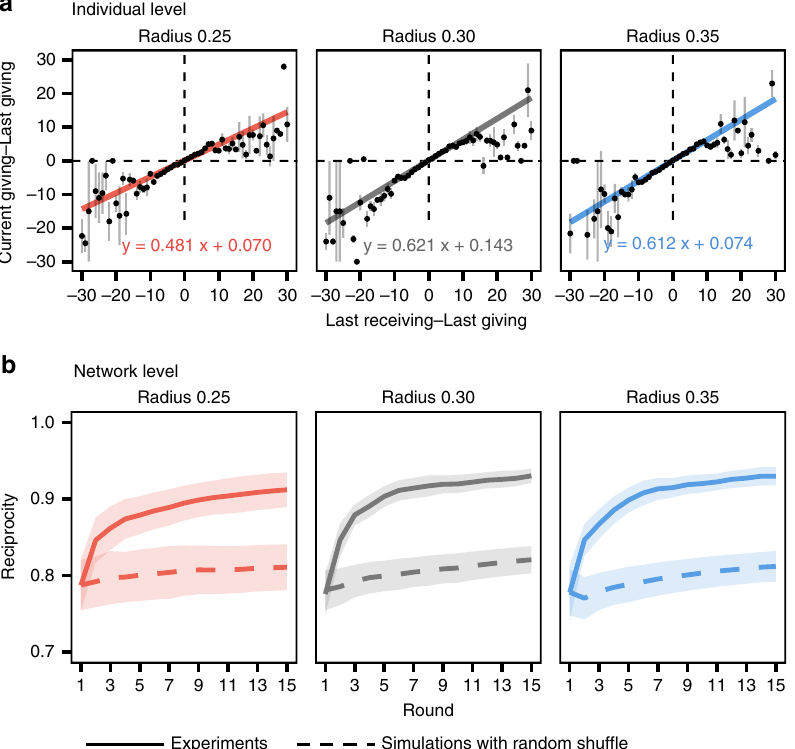
Fig. 5 Subjects reciprocate to their neighbors. a Individual-level reciprocity. The graphs show how much a subject increases (or decreases) their share based on the last transaction balance they had with each one of their neighbors. Dots indicate the average of actual data. Error bars are standard errors. Colored lines are the estimated result of regression analysis with nested random effects for round and individuals. On average, subjects raise their allocations when their neighbor were generous, i.e., gave more than they had received from the egos (so had positive values on the X- axis), as indicated by the positive slopes of the regression line ( P < 0.01 for all the radius treatments). The reciprocal tendency is smaller in the network of radius 0.25, compared to in that of radius 0.30 or 0.35. b Changes in network-level reciprocity across rounds. The reciprocity of the weighted networks is calculated by dividing the total reciprocated resources (i.e., the sum of symmetric sharing) by the total shared resources in the network. The solid lines show the average of experimental results; the dashed lines show the expected value when each individual randomly allocates their resources while keeping the diversity of the observed allocation from the experiments. Shaded areas denote 95% con fi dence intervals ( N =